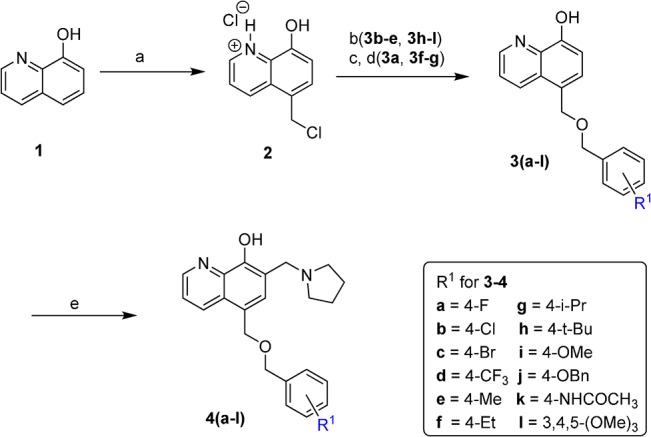
Synthesis of compounds 4a-4l.Reagents and conditions: (a) conc. HCl, ZnCl2, HCHO(37% in H2O); (b) substituted benzyl alcohol, NaH, THF, reflux; (c) substituted benzyl alcohol, 110 oC; (d) NH4OH, H2O, Et2O, pH 8–10; (e) paraformaldehyde, pyrrolidine,EtOH, reflux.